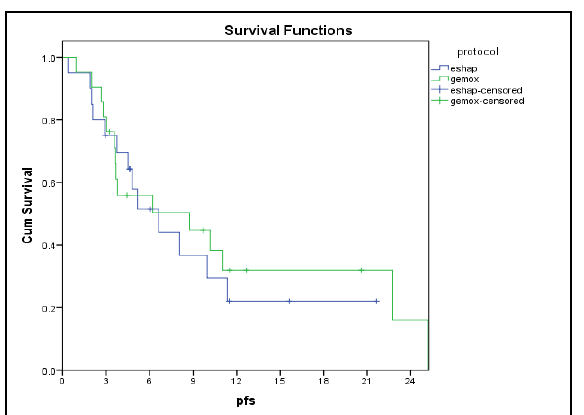
Figure 1. Progression free survival curves of GEMOX and ESHAP arms